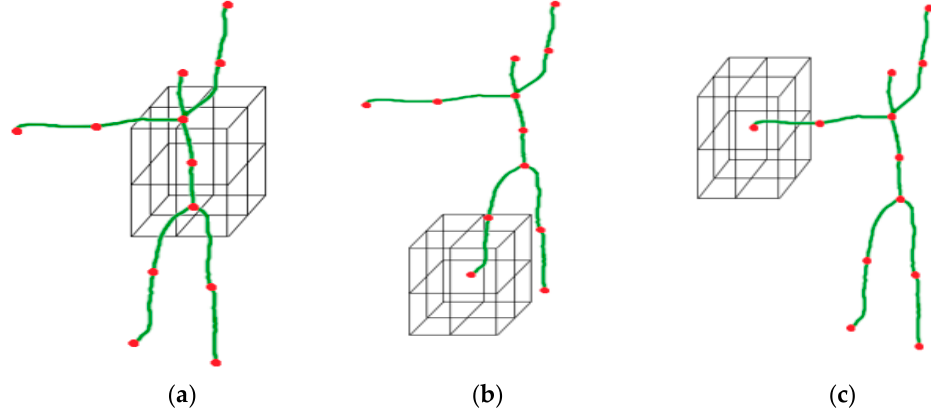
( b ) Figure 7. Kinematic posture. ( a ) Linear joint position feature (LJPF), ( b ) angular joint position feature (AJPF). 3.4.4. Point-Based Feature: LOP The local occupancy pattern (LOP) [48] of each key body part is obtained as a point- based feature. It measures the space occupied by an object around a certain body part. For example, when a person picks up a glass, the space around his/her hand is occupied by that glass. Then if the person drinks from that glass, the space around both the hand and the head is occupied by the object. This occupancy information can be useful for identifying the interaction of drinking from other HOIs. For each joint, the local region of size (72, 72, 320) around it is partitioned into 12 × 12 × 4 bins, and the size of each bin is (6,